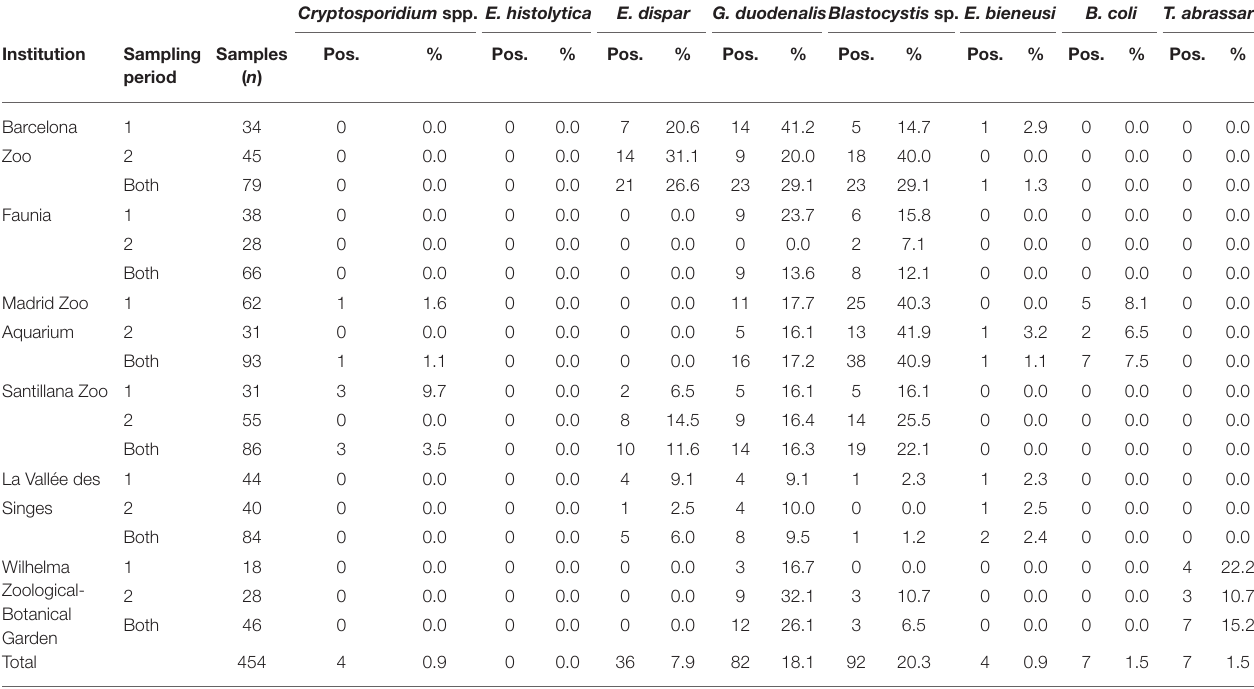
TABLE 1 | Frequency of intestinal protist species detected in captive non-human primates by participating institution and sampling period in the present